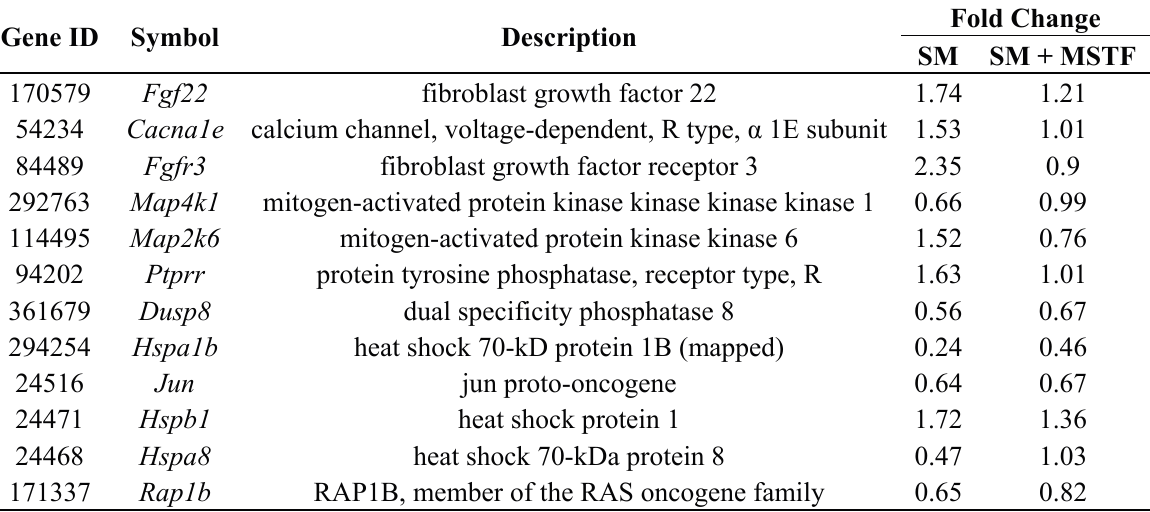
Table 2. List of 12 genes involved in the MAPK signaling pathway. These SM-induced alterations of expression were abolished or attenuated by MSTF treatment.